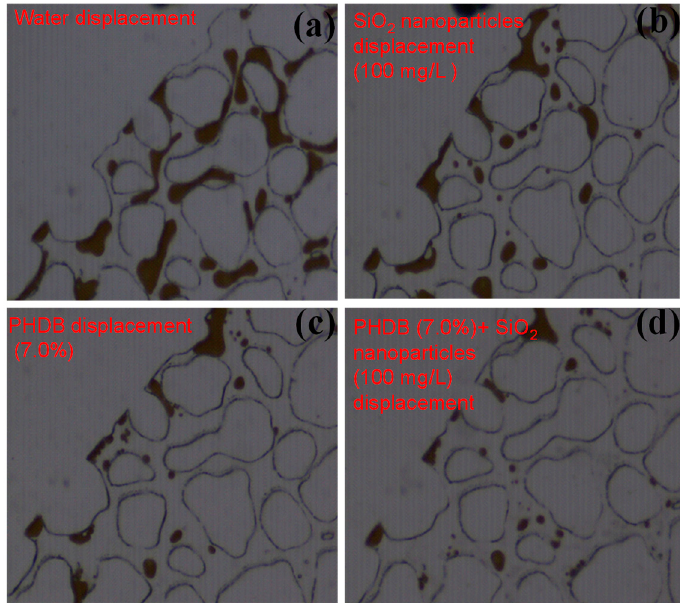
Figure 6. Mobilization characteristics of residual oil in boundary dead-end areas under different displacement fluids. ( a ) After water flooding, ( b ) 100 mg/L of SiO 2 nanoparticle displacement, ( c ) 7.0% of PHDB displacement, and ( d ) PHDB (7.0%)-SiO 2 nanoparticles (100 mg/L) composite displacement.